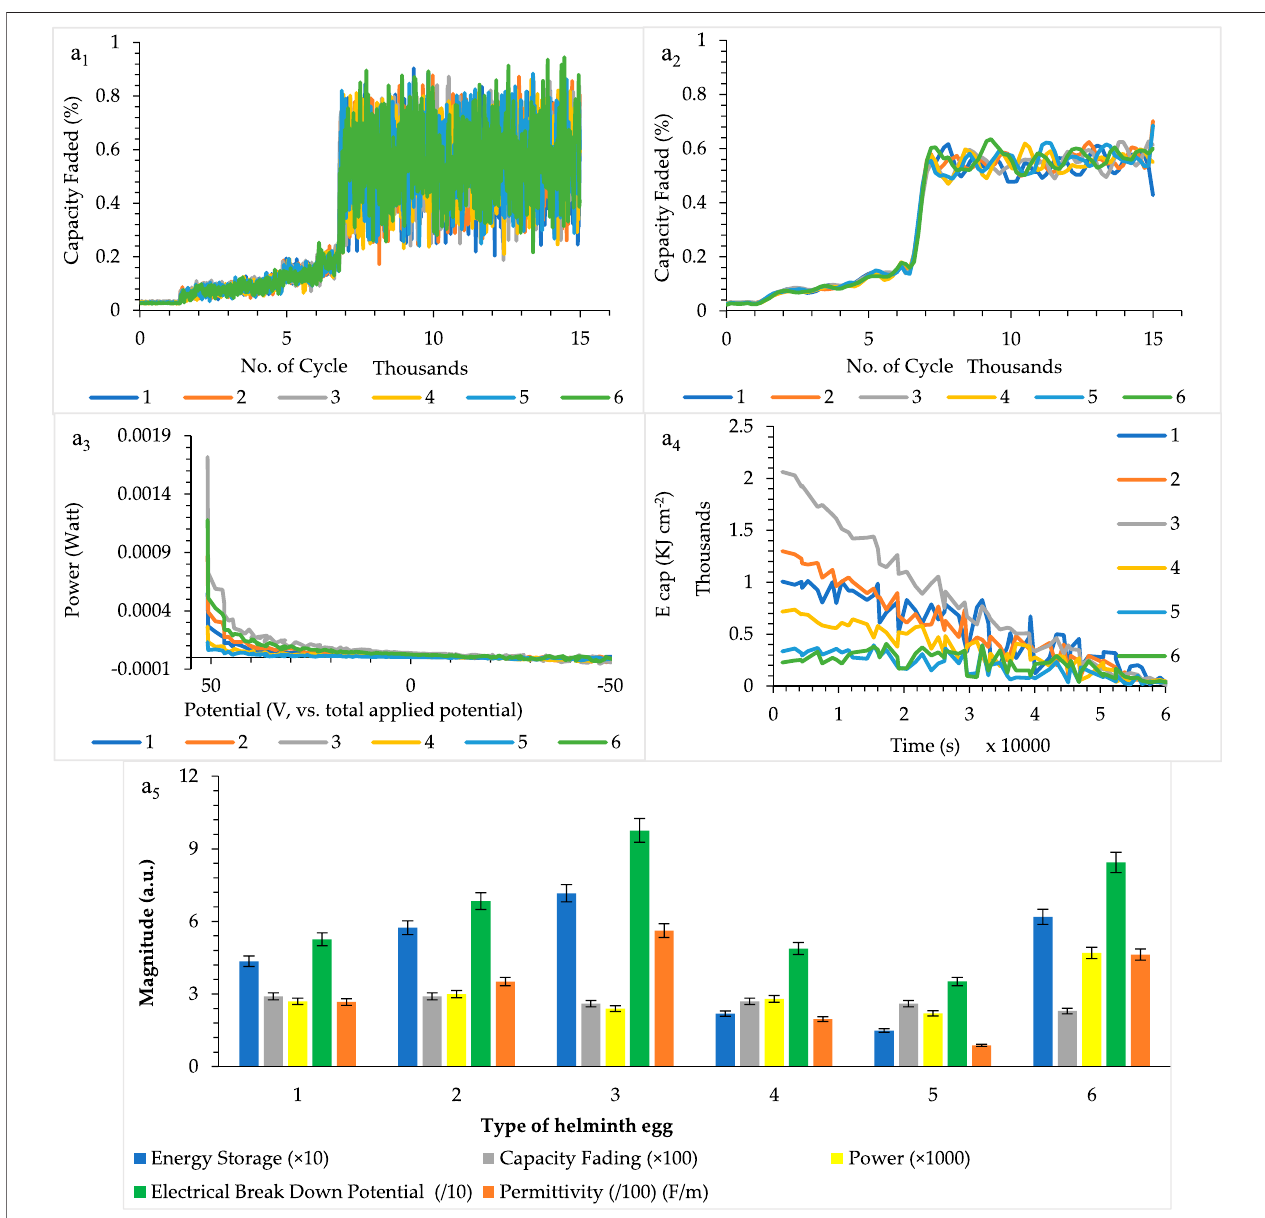
FIGURE5|(A) Relatedcapacityparameter[includingcapacityfading(nonsmoothedandsmoothed),power,energystorage,permittivity,andelectricalbreakdown potential] for a single egg (a 1 – a 5 ), for fi ve independent repeats during implanting of three microelectrodes with 0.0124 ± 0.0008 mm interelectrode distance, error bar: ± standard deviation ( n (cid:2) 5). Note that to prevent clutter, error bars are eliminated in parts (a